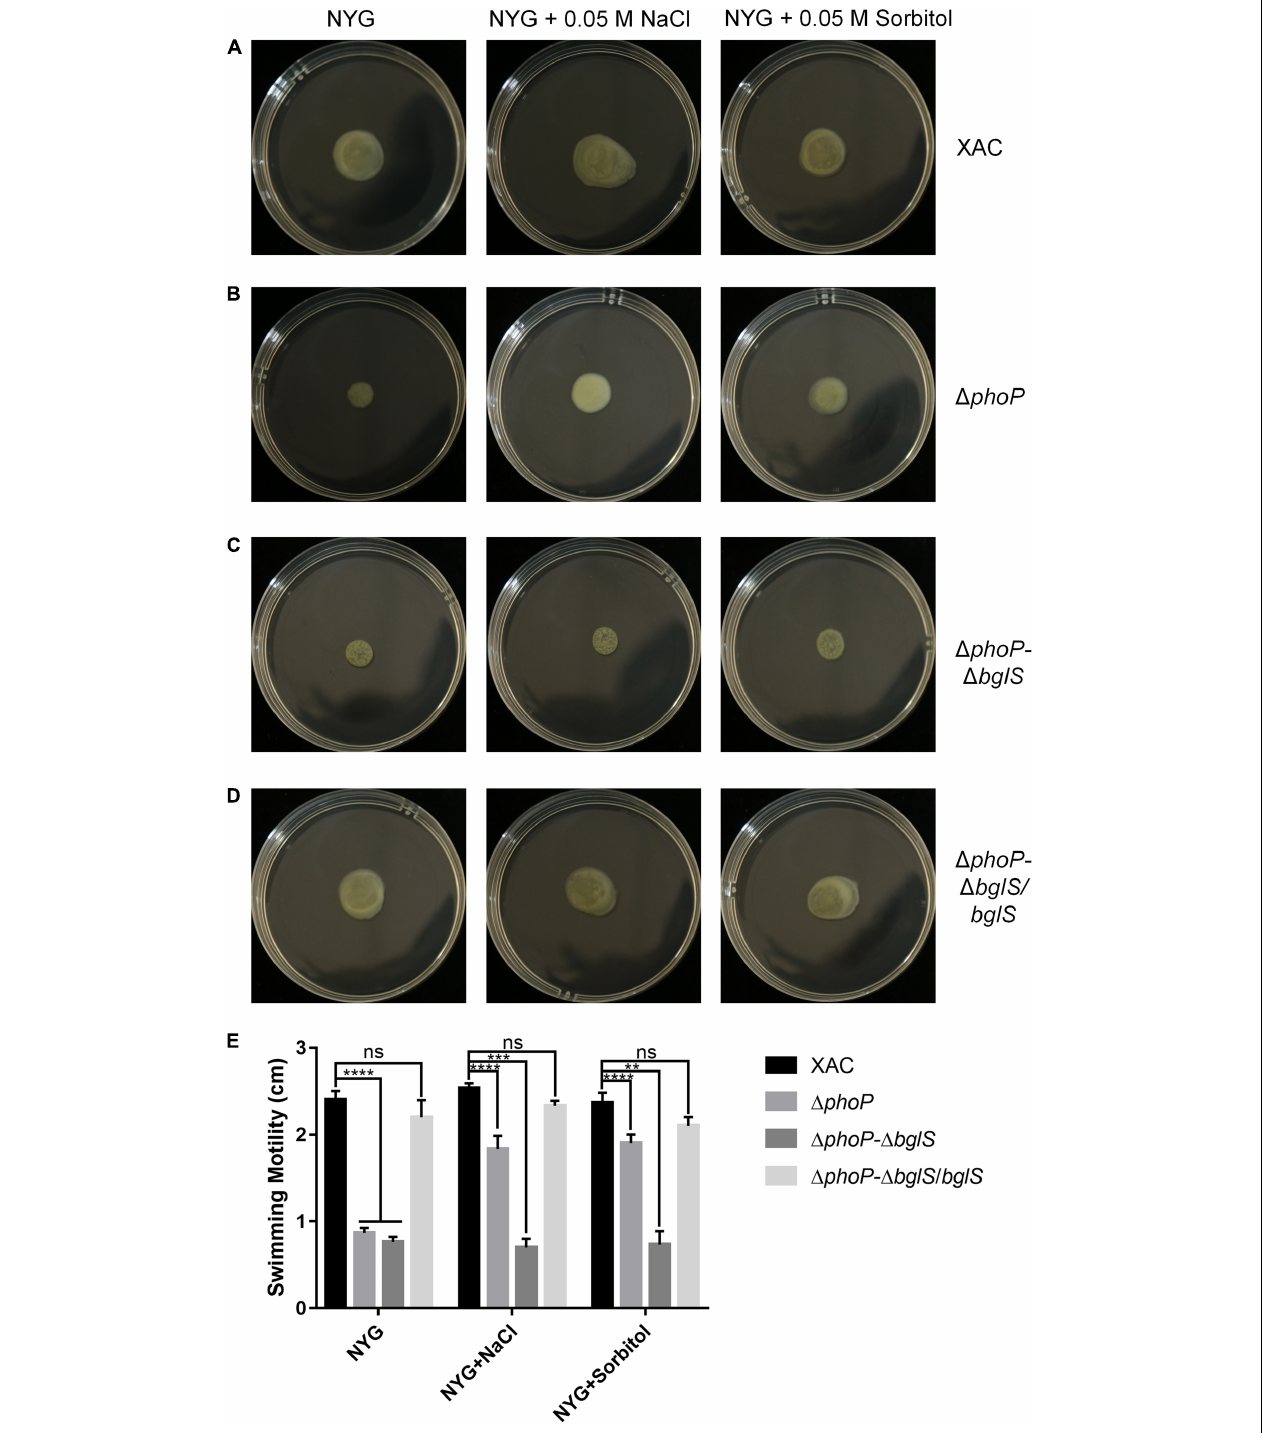
FIGURE 5 | Critical role of BglS in reversing the swimming motility disadvantage of phoP mutant. (A) Swimming motility of X. citri wild-type strain on rich NYG medium plates or NYG medium plates supplemented with 0.05 M NaCl or 0.05 M sorbitol. (B) Swimming motility of phoP mutant strain on rich NYG medium plates or NYG medium plates supplemented with 0.05 M NaCl or 0.05 M sorbitol. (C) Swimming motility of phoP and bglS double mutant strain ( (cid:49) phoP - (cid:49) bglS ) on rich NYG medium plates or NYG medium plates supplemented with 0.05 M NaCl or 0.05 M sorbitol. (D) Swimming motility of bglS overexpression in phoP and bglS double mutant strain ( (cid:49) phoP - (cid:49) bglS/bglS ) on rich NYG medium plates or NYG medium plates supplemented with 0.05 M NaCl or 0.05 M sorbitol. (E) Statistical analysis BglS role in reversing the swimming motility disadvantage of phoP mutant. Error bars, means standard deviations ( n = 3). ** P < 0.01, *** P < 0.001, and **** P < 0.0001, assessed by one-way ANOVA. All experiments were repeated three times with similar results.